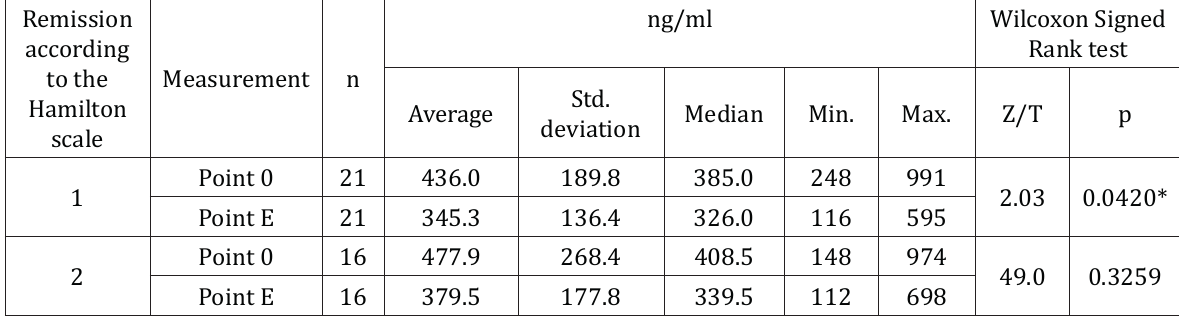
Table 9. Descriptive statistics – Concentration of MMP-9 in patients at different stages of remission according to the HDRS at two points in time and the results of a Wilcoxon Signed Rank test.